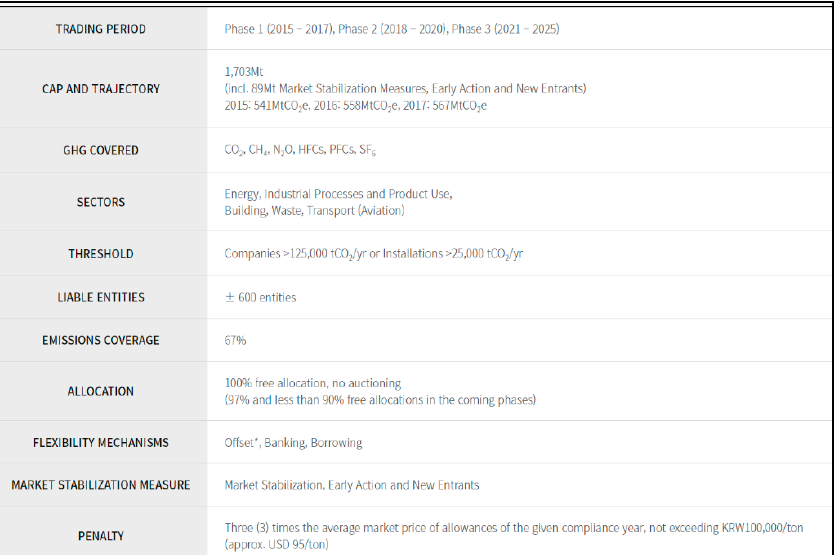
Figure 1. Korean ETS. Source: [28] ECOEYE, 2021.